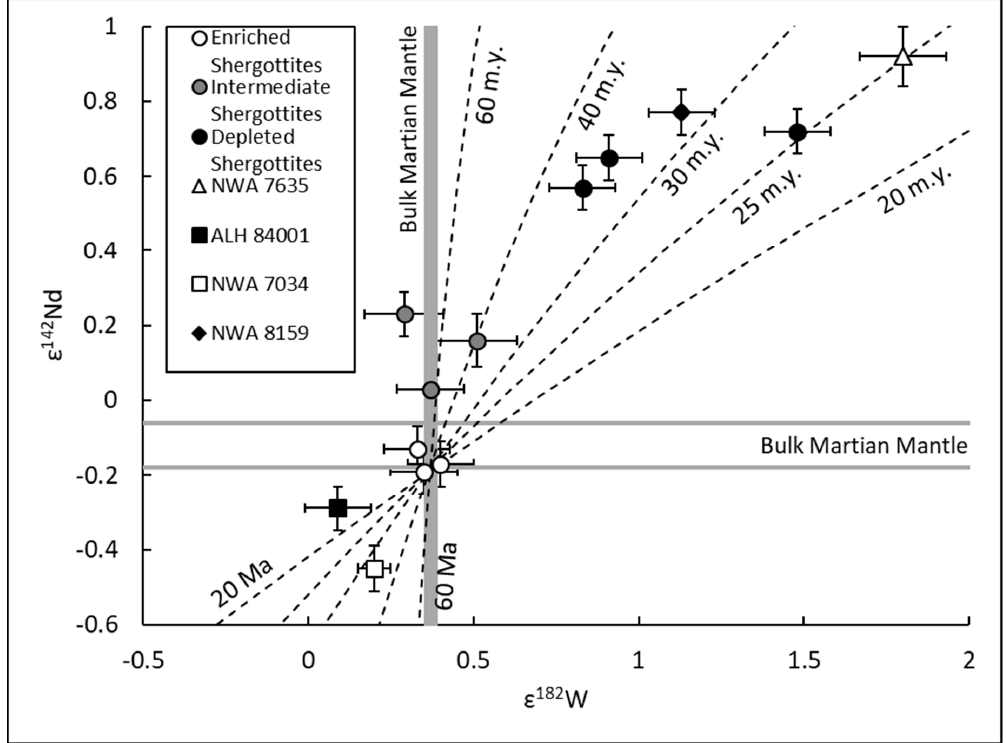
Figure 4. ε 182 W vs. ε 142 Nd for Martian meteorites. Grey horizontal lines are the ranges of potential Martian bulk ε 142 Nd values [15,87], and grey vertical line is the range of Martian bulk ε 182 W, deduced from these values and Martian meteorite ε 182 W. Dashed lines represent model times for source differentiation after solar system formation. Data and model calculations from ref. [16] and references within.